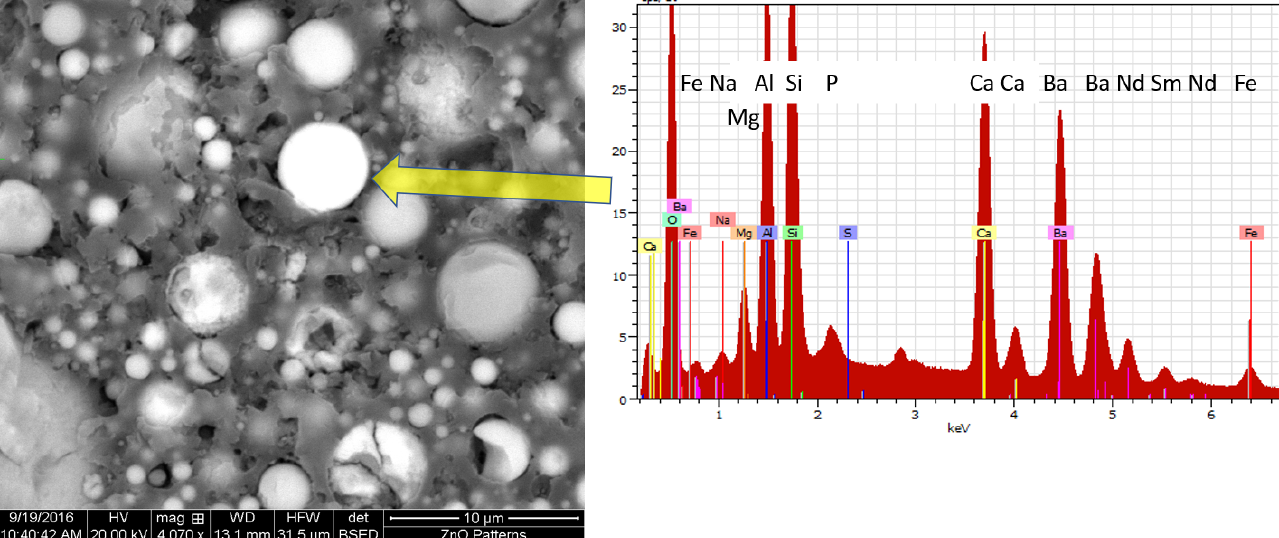
Figure 5. Left/ Back-scatter image of REE-bearing grain. Scale = 10 μ m. Right/ EDS spectrum of ele- Figure 5. Left/Back-scatter image of REE-bearing grain. Scale = 10 µ m. Right/EDS spectrum of